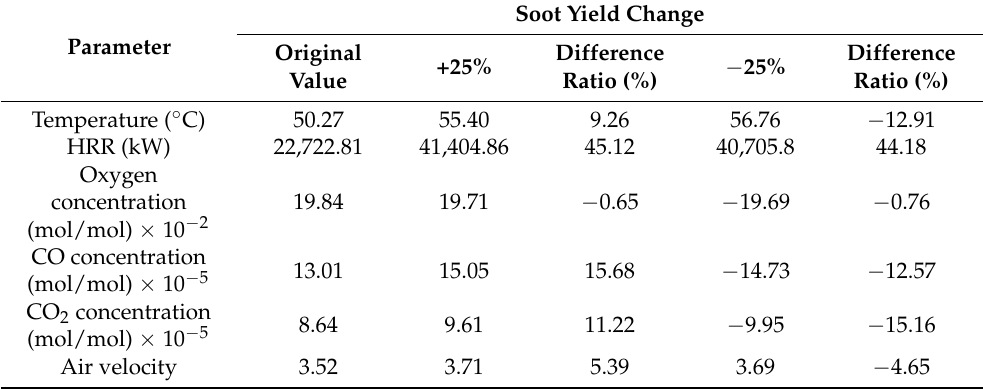
Table 8. Effects of soot yield.